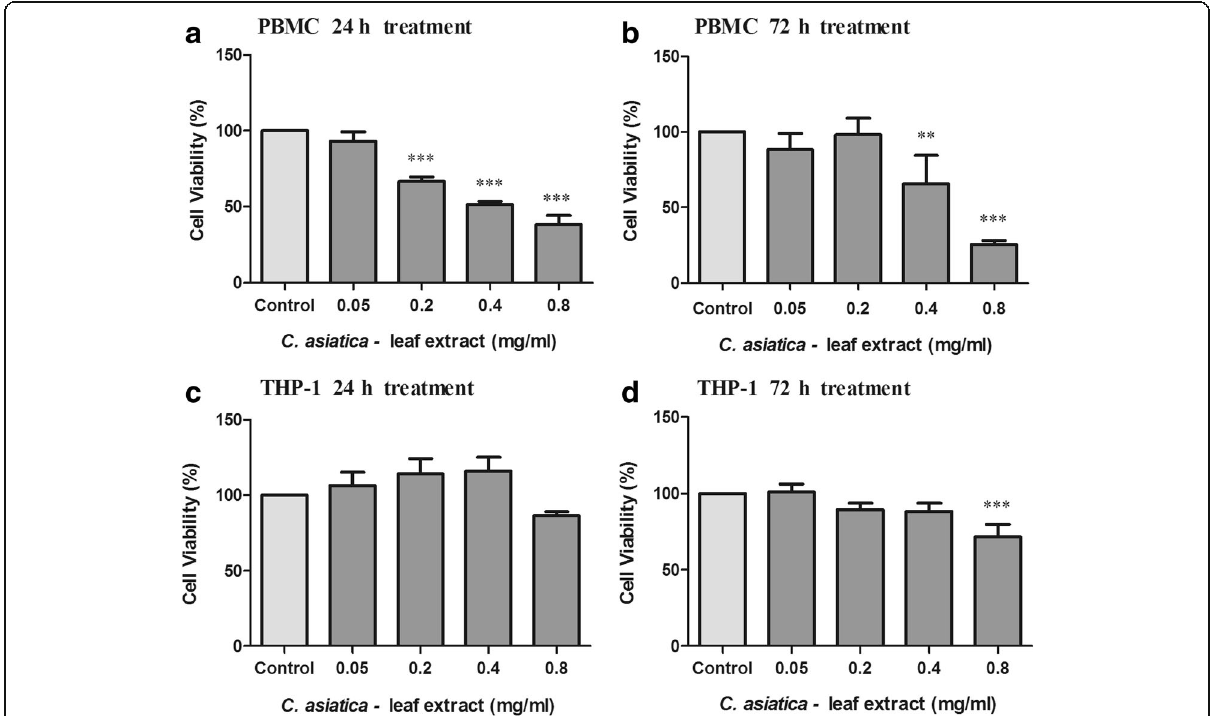
Fig. 2 Cell viability of PBMC ( a – 24 h, b – 72 h) and THP-1 ( c – 24 h, d – 72 h) cells treated with C LE for 24 and 72 h (Values expressed as